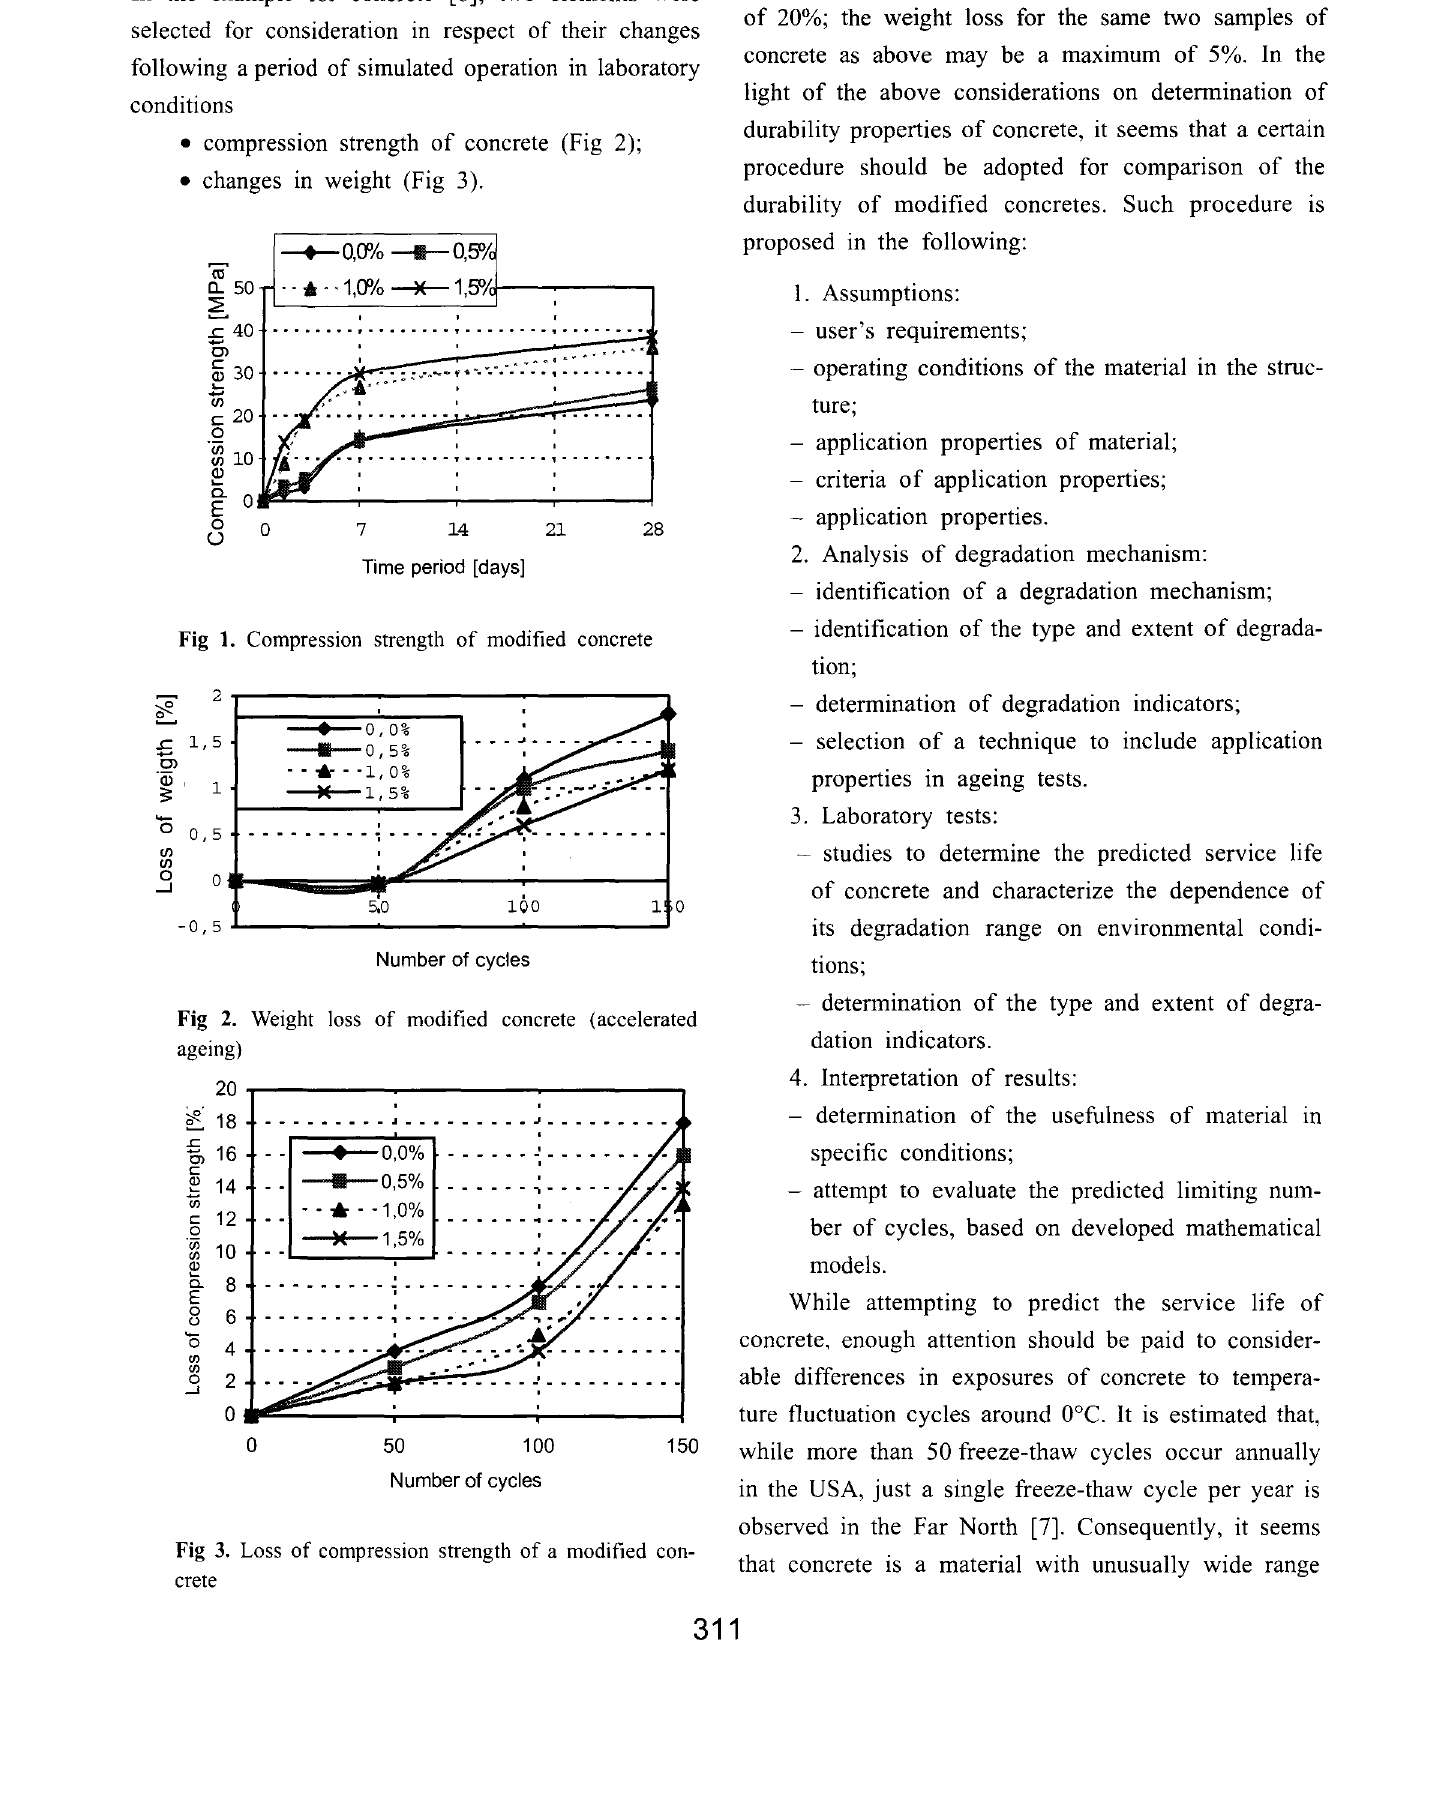
Fig 3. Loss of compression strength of a modified